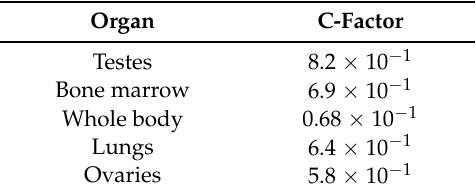
Table 1. Average values of C-factors for different organs or tissues taken from